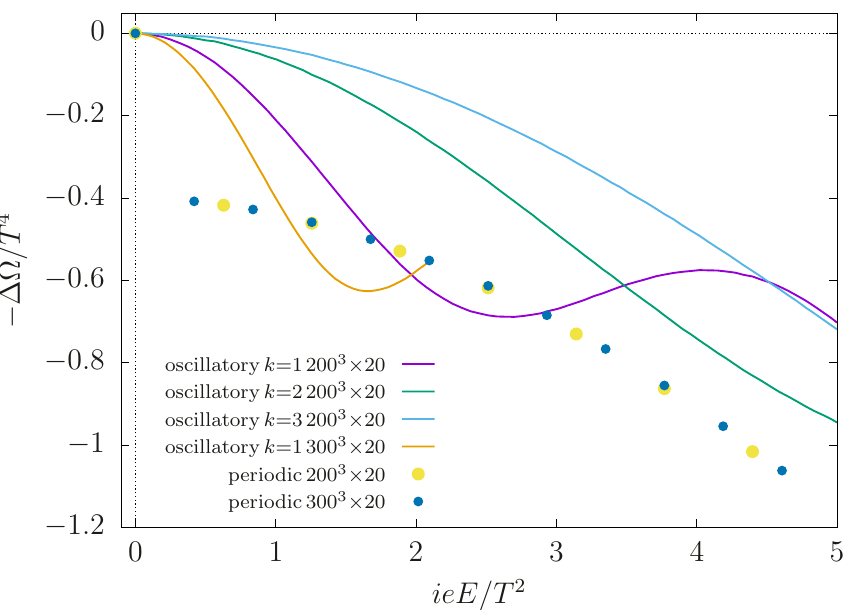
Figure 4 . The imaginary electric field dependent part of the grand canonical free energy density as a function of the amplitude of the field strength. The lines represent oscillatory electric fields with different wavelengths, while the dots mark the results for homogeneous fields. Both setups show that towards the thermodynamic limit the grand canonical free energy density develops a discontinuous behaviour at E = 0